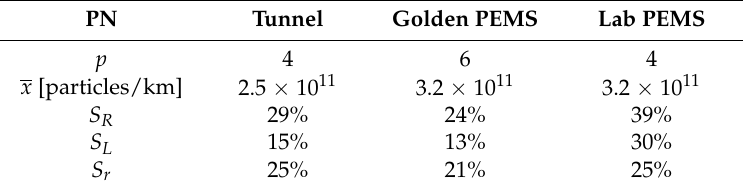
Table A4. Statistical analysis results for